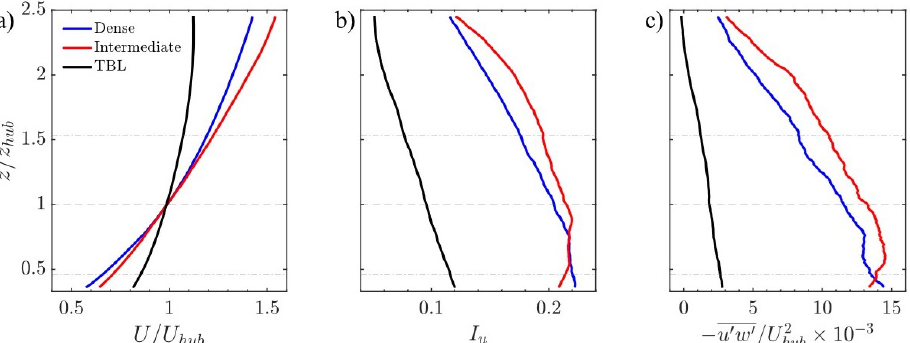
Figure 2. Characteristics of the incoming turbulent boundary layers. ( a ) Mean velocity U / U hub , ( b ) streamwise turbulence intensity I u = σ u / U hub , and ( c ) kinematic shear stress − u (cid:48) w (cid:48) / U 2